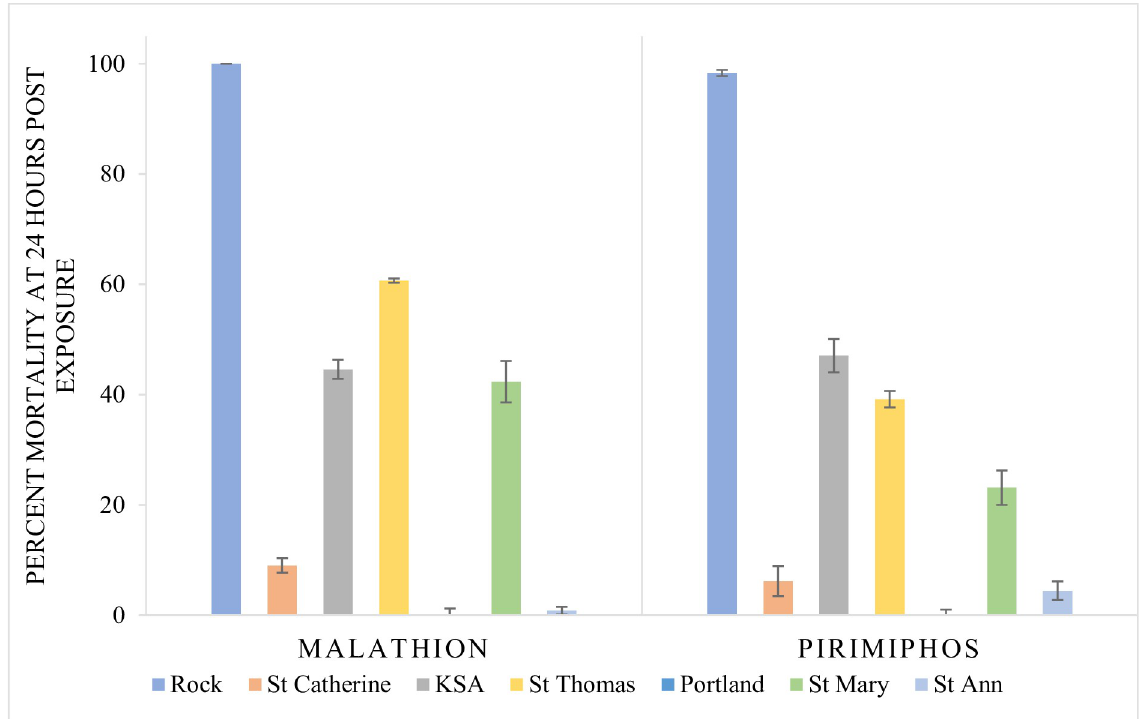
Fig 4. Percentage Mortality of Ae . aegypti Exposed to Baseline Concentrations of 0.8% Malathion or 0.21% Pirimiphos After 24-Hour Exposure. The effect of 0.8% malathion or 0.21% pirimiphos at 24 hours on 2–5 day old Aedes aegypti females reared from eggs collected from the eastern parishes of Jamaica. The data are summarized as mean ± 95%